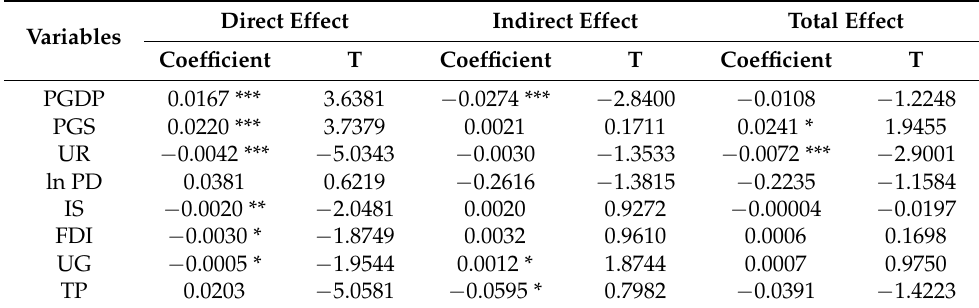
Table 6. The spatial spillover effect of the EWP.